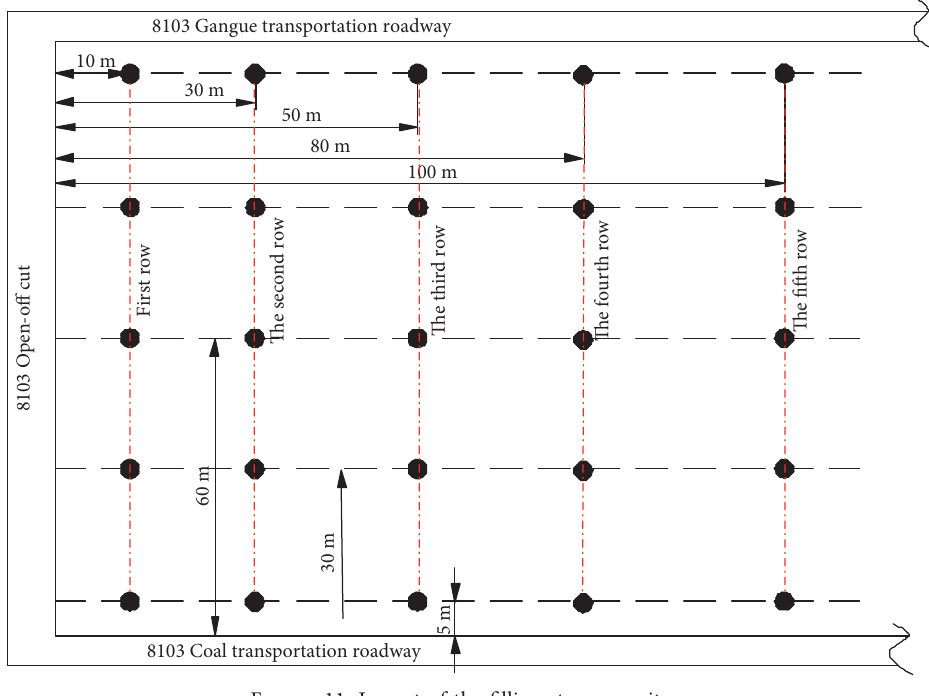
Figure 11: Layout of the filling stress monitor.